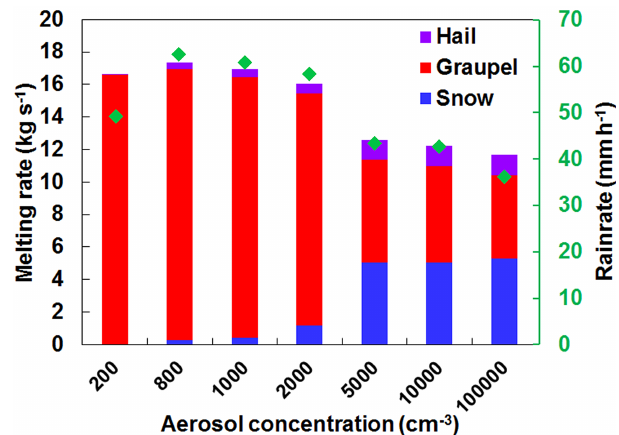
Figure 14. The correlation of rain rate and the melting rate of the frozen particles. The green diamond points are the averaged rain rate under different aerosol concentrations (FF = 10 5 Wm − 2 ). The columns represent the integrated melting rate from individual frozen